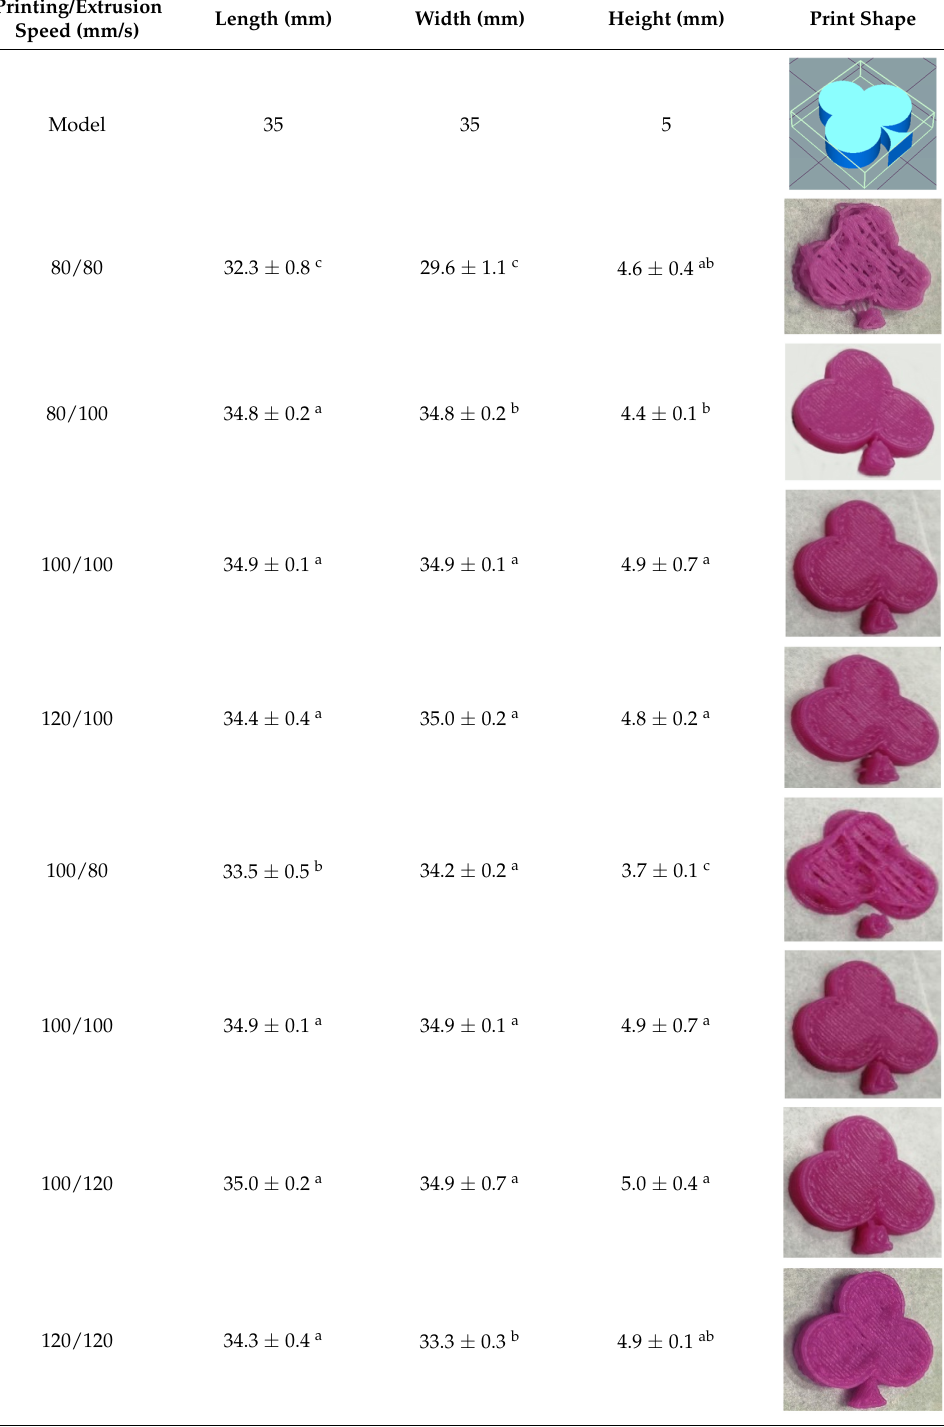
Table 3. Effect of printing/extrusion speed on 3D printing of AS